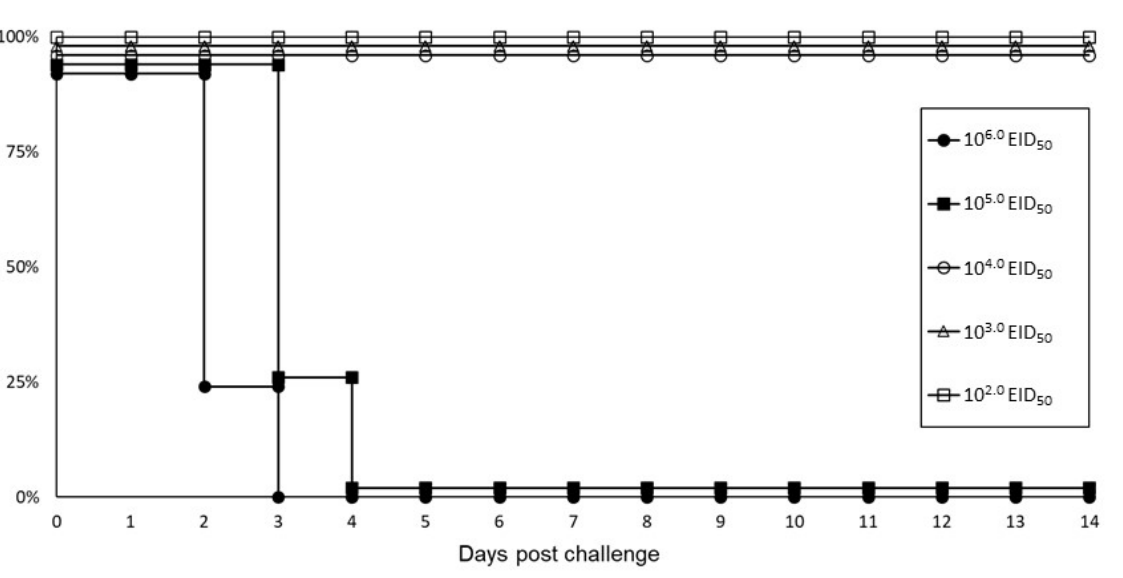
Figure 3. Survival curve of chickens intranasally inoculated with A/crow/Hokkaido/0103B065/2022 (H5N1). Five groups of four 6-week-old chickens were intranasally inoculated with 10 2.0 , 10 3.0 , 10 4.0 , 10 5.0 , and 10 6.0 times of EID 50 of A/crow/Hokkaido/0103B065/2022 (H5N1), respectively, and observed for 14 days after virus challenge. Clinical manifestations of chickens were observed, and their survivals were recorded daily to calculate the survival rate of each group per day.